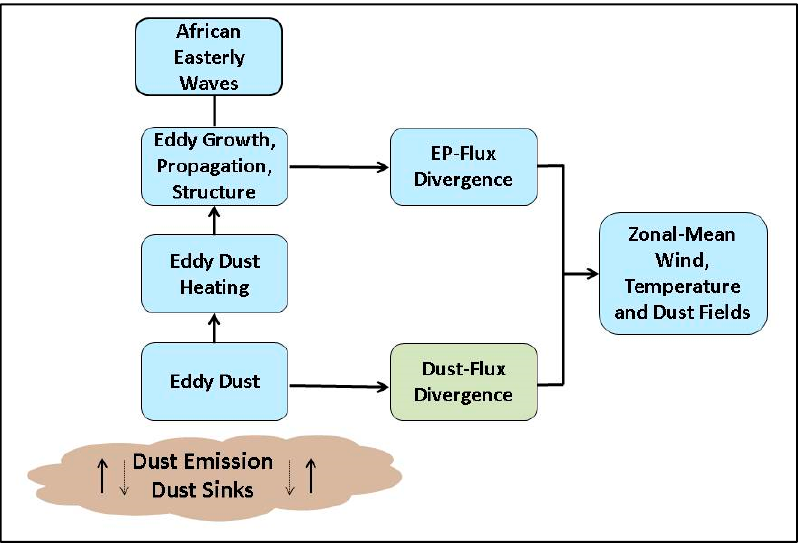
Figure 3. Schematic of the linear dynamics of dust-modified African easterly waves (AEWs) and their corresponding Eliassen-Palm (EP) and dust flux divergences, which affect the zonal-mean wind, temperature, and dust field tendencies. The pathways that connect the linear response of the AEWs to the direct radiative effects of dust (blue boxes) have been examined by Grogan et al. [26,27] and Nathan et al. [28]. The eddy dust transports, which are contained within the dust flux divergence (green box), are the focus of this study. See text for additional details.